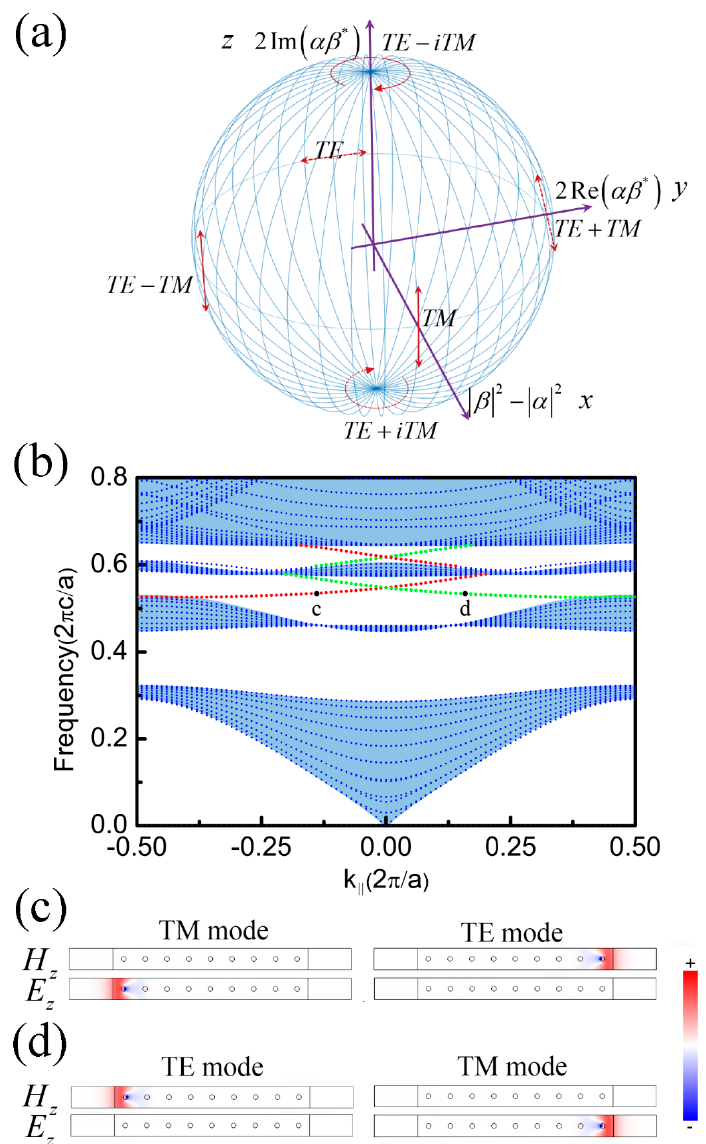
Figure 1. Bloch sphere and energy band of supercell. ( a ) Choose | β | 2 − | α | 2 , 2Re ( αβ ∗ ) , and 2Im ( αβ ∗ ) of the two-component vector ( α , β ) T , e.g., TE = ( 1,0 ) T , TM = ( 0,1 ) T , to be the x-, y-, and z-components of 3D space. The polarizations transverse electric (TE)/transverse magnetic (TM), TE + TM/TE − TM, and TE + i TM/TE − i TM are the unit vectors on three main axes. ( b ) The projected band structures of the photonic topological insulator (PTI). Gapless edge states are denoted by green and red dotted lines. ( c ) and ( d ) correspond to the field (both electric and magnetic) distribution of points c and d in Figure 1b, respectively. The color represents the value of the E z or H z